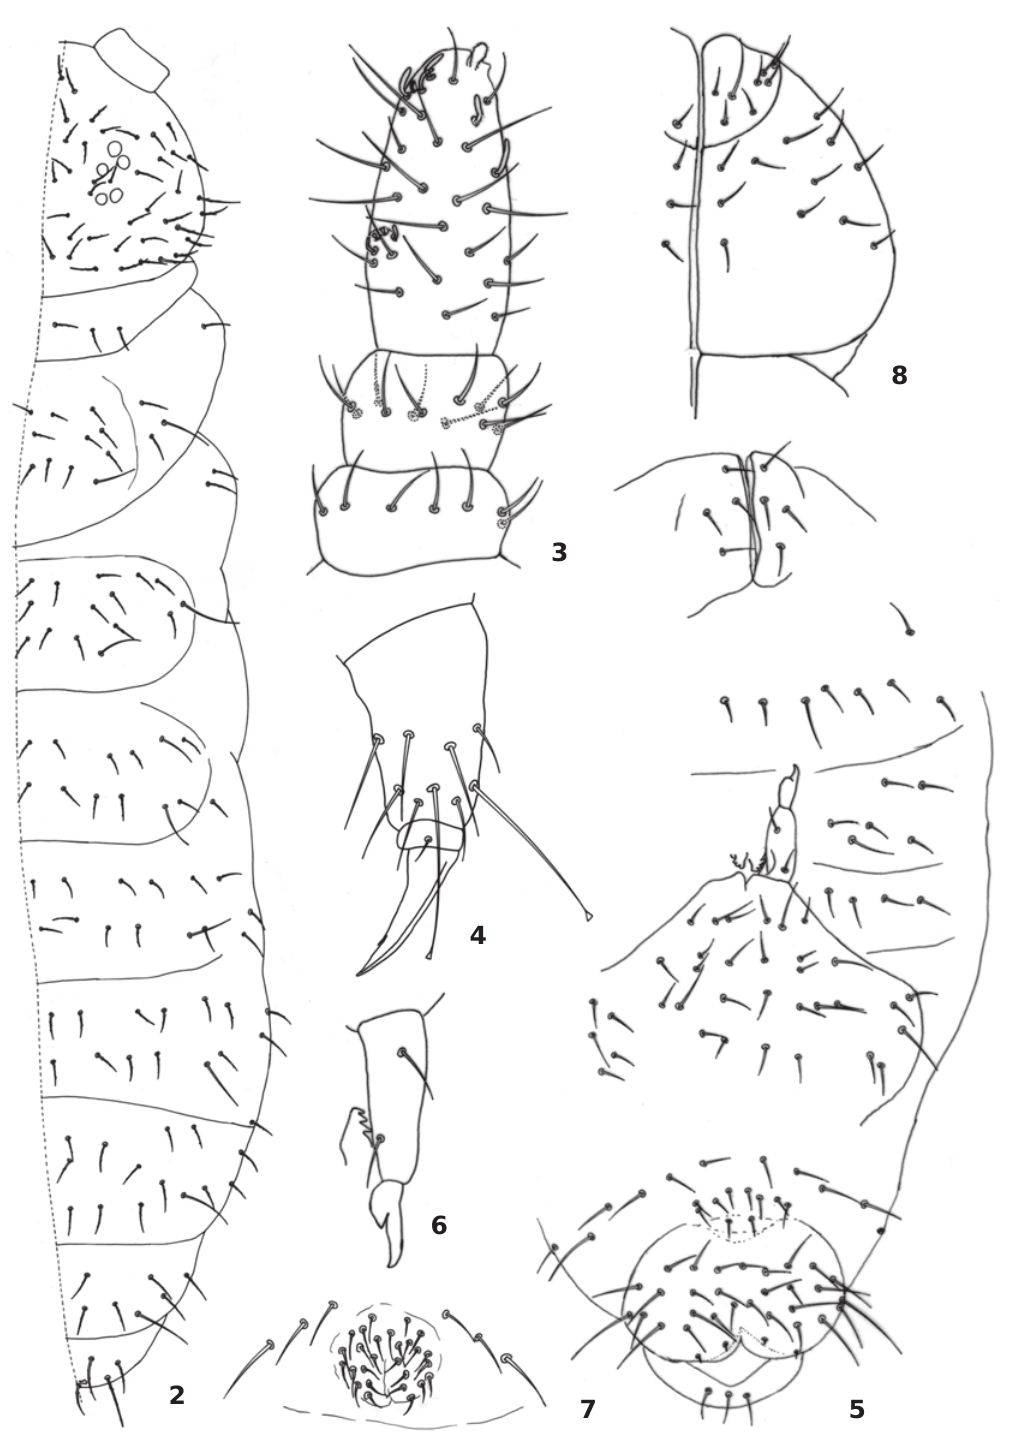
Figures 2-8. Xenylla capixaba sp. nov. : (2) dorsal chaetotaxy; (3) antenna; (4) unguis and tibiotarsus I; (5) abdominal ventral chaetotaxy; (6) retinaculum, dens and mucro; (7) genital plate of male; (8) cephalic ventral